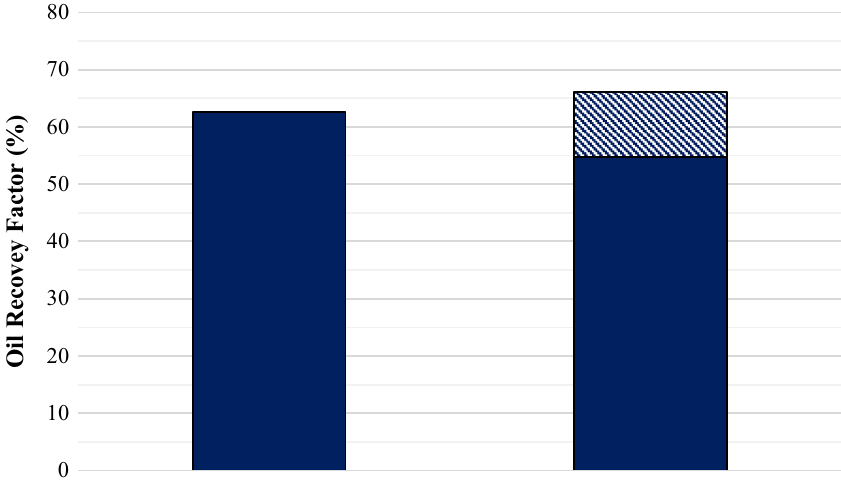
Fig. 10 Effect of divalents on oil recovery in comparison with SW. The dashed part indicates that removing monovalents from the injected solution resulted in roughly 4% higher oil recovery compared to SW